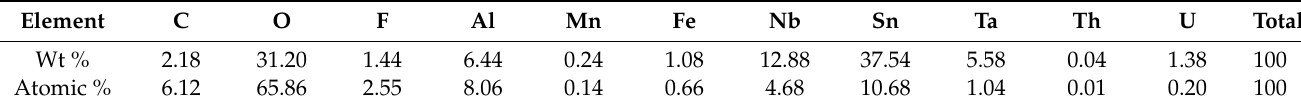
Table 1. Elemental percentage of tantalum-niobium slag by EDS.